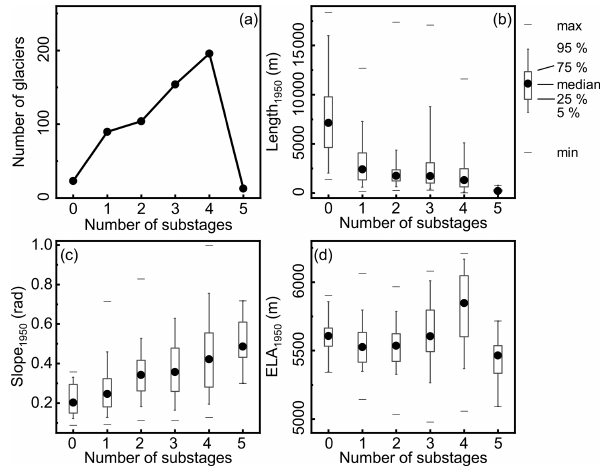
Figure 5. (a) The identified glacial substage number distribution in the MC experiment. The relationship between the identified glacial substages with (b) glacier length, (c) glacier slope, and (d) glacial ELA at 1950 in the MC experiment.